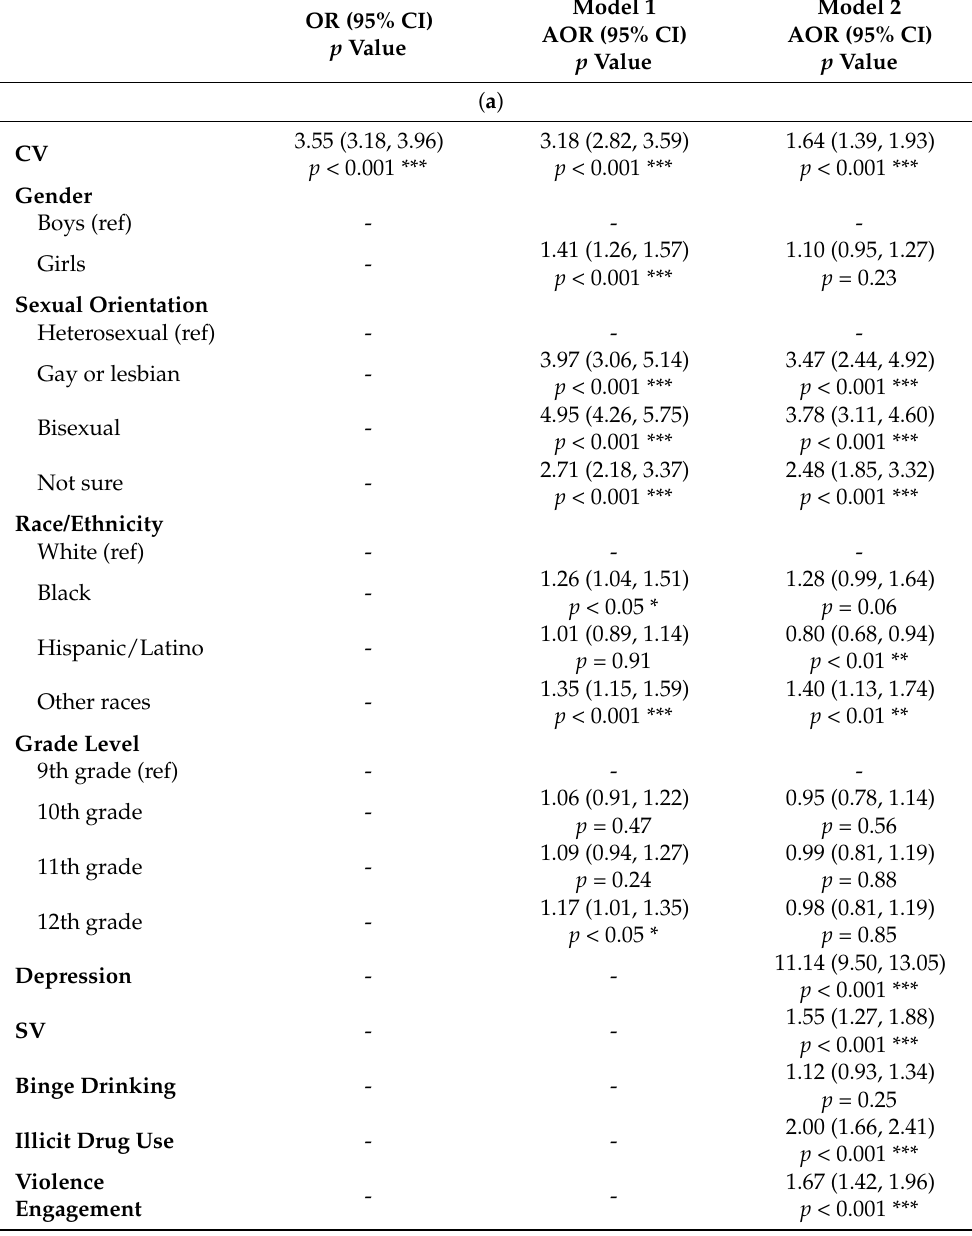
Table 2. ( a ) Simple logistic regression and logistic multiple regression results for the relationship between CV and suicidality by demographic and behavioral risks among a representative sample of U.S. high school students ( n = 10,309). ( b ) Simple logistic regression and logistic multiple regression results for the relationship between CV and suicidality by demographic and behavioral risks among a representative sample of U.S. high school students, female subsample ( n = 5333). ( c ) Simple logistic regression and logistic multiple regression results for the relationship between CV and suicidality by demographic and behavioral risks among a representative sample of U.S. high school students, male subsample ( n = 4976). OR (95%